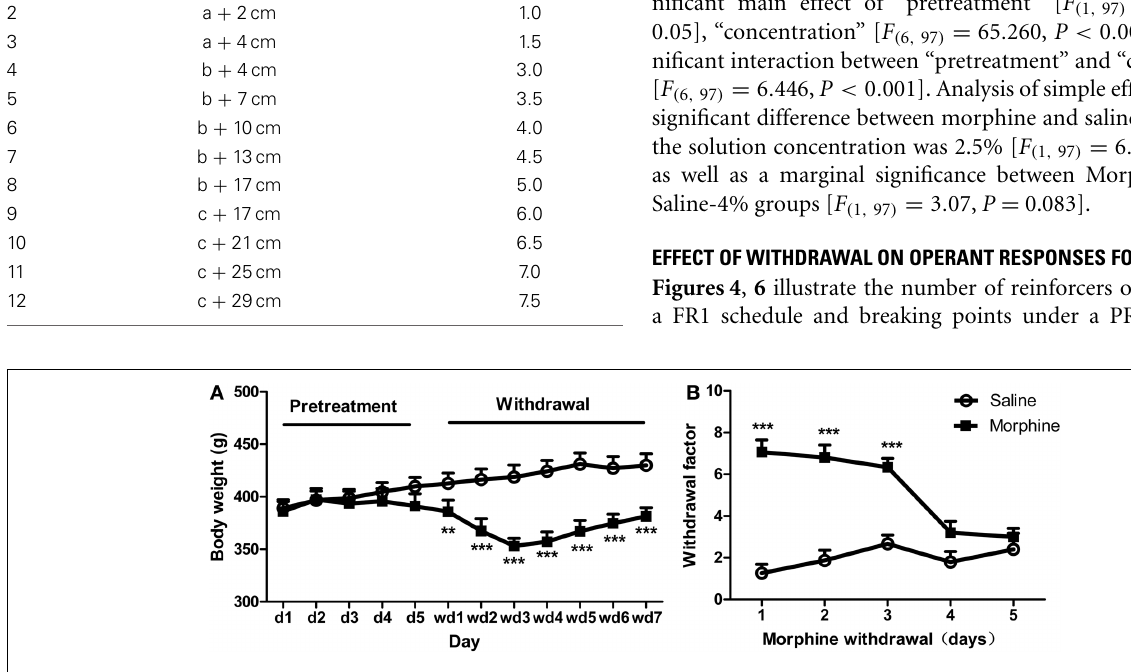
following the cessation of daily morphine or saline injections. ∗∗ P < 0 . 01, ∗∗∗ P < 0 . 001, relative to saline animals. Values are mean ±